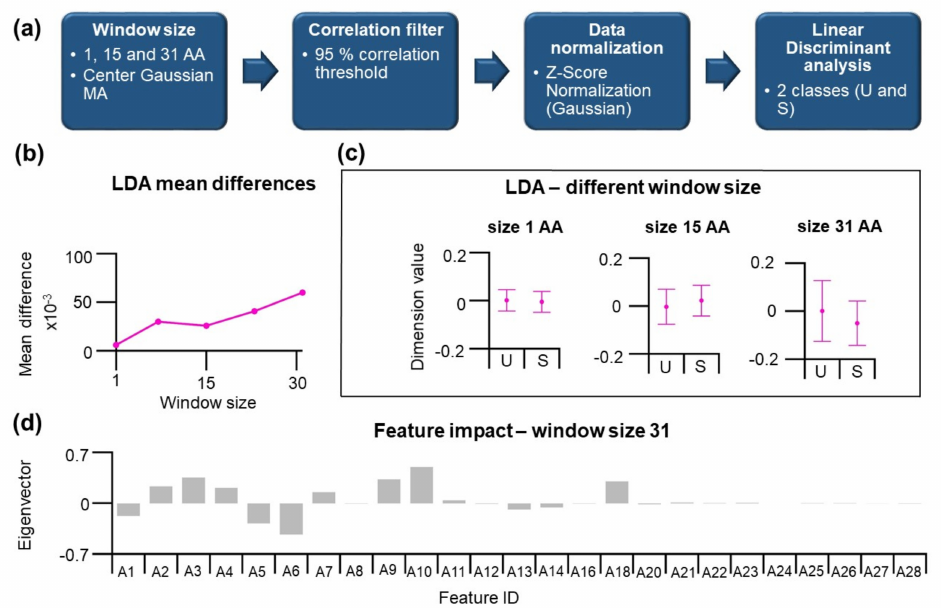
Figure 5. The application of the LDA method on data using feature values at different window sizes. ( a ) Workflow for the LDA method. ( b ) LDA mean differences of U and S classes—dimensions values as a function of window size. LDA difference increases with window size. ( c ) A closer look at dimension values at 1, 15, and 31 window size. ( d ) Eigenvectors values for the features at 31 aa window